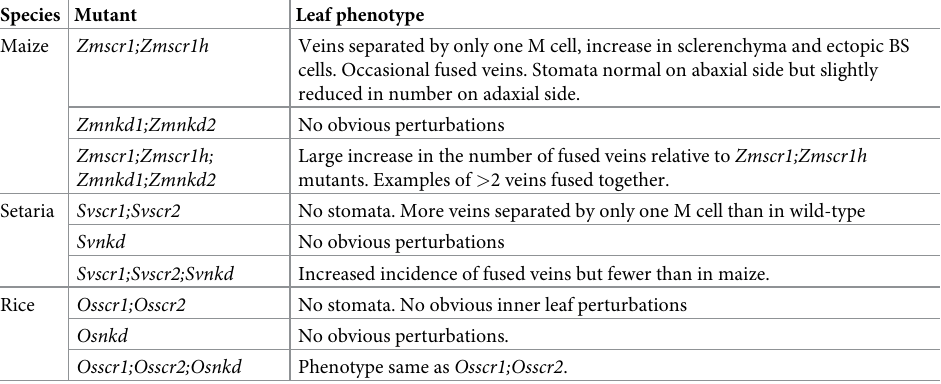
Table 1. Summary of the leaf phenotype of maize, setaria and rice scr , nkd and scr;nkd mutants from this study and previous work [4,5]. Species Mutant Leaf phenotype Maize Zmscr1;Zmscr1h Veins separated by only one M cell, increase in sclerenchyma and ectopic BS cells. Occasional fused veins. Stomata normal on abaxial side but slightly reduced in number on adaxial side. Zmnkd1;Zmnkd2 No obvious perturbations Zmscr1;Zmscr1h;